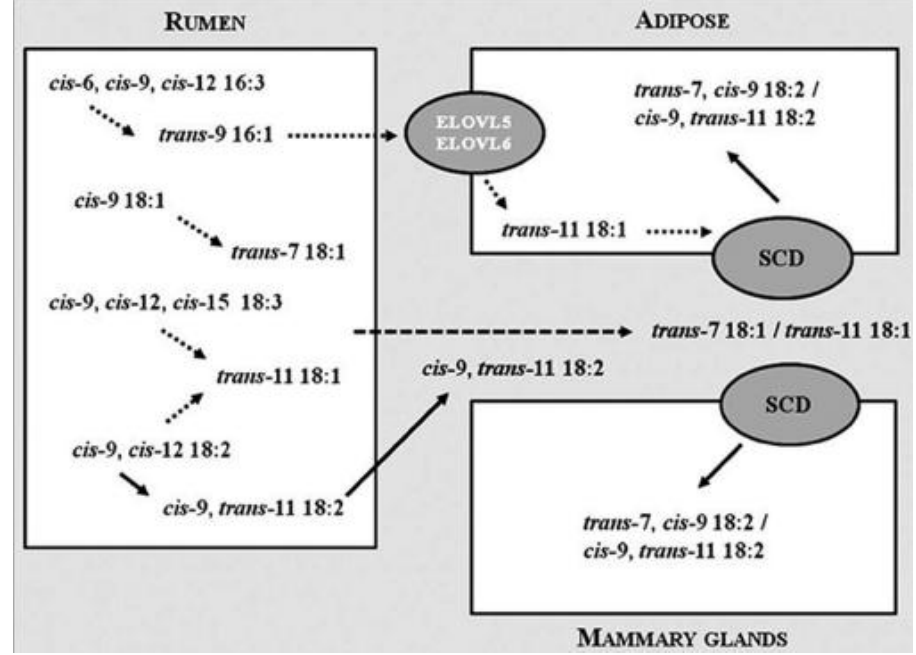
Figure 4. Metabolic pathways of endogenous conjugated linoleic acid synthesis in ruminants. Adopted, with permission, from [45]. Copyright 2014, Royal Society of Chemistry.